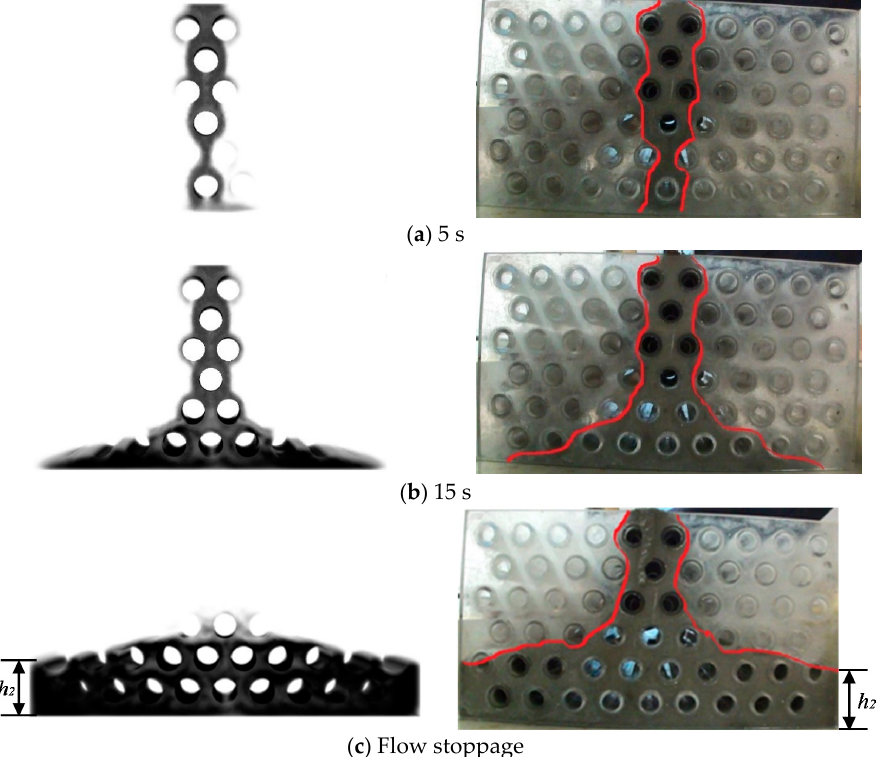
Figure 3. The flow process of SCM in the porous box (left: simulation; right: test [10]). ( a ) 5 s; ( b ) 15 s; ( c ) Flow stoppage.